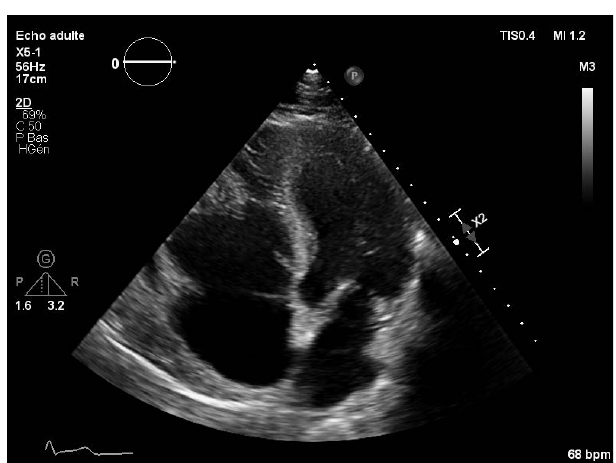
Fig. 1 - Obliteration of the right ventricle in the apical region, with polylobed mass in the right ventricular outflow tract. Note the thickened endocardium and the tricuspid annulus